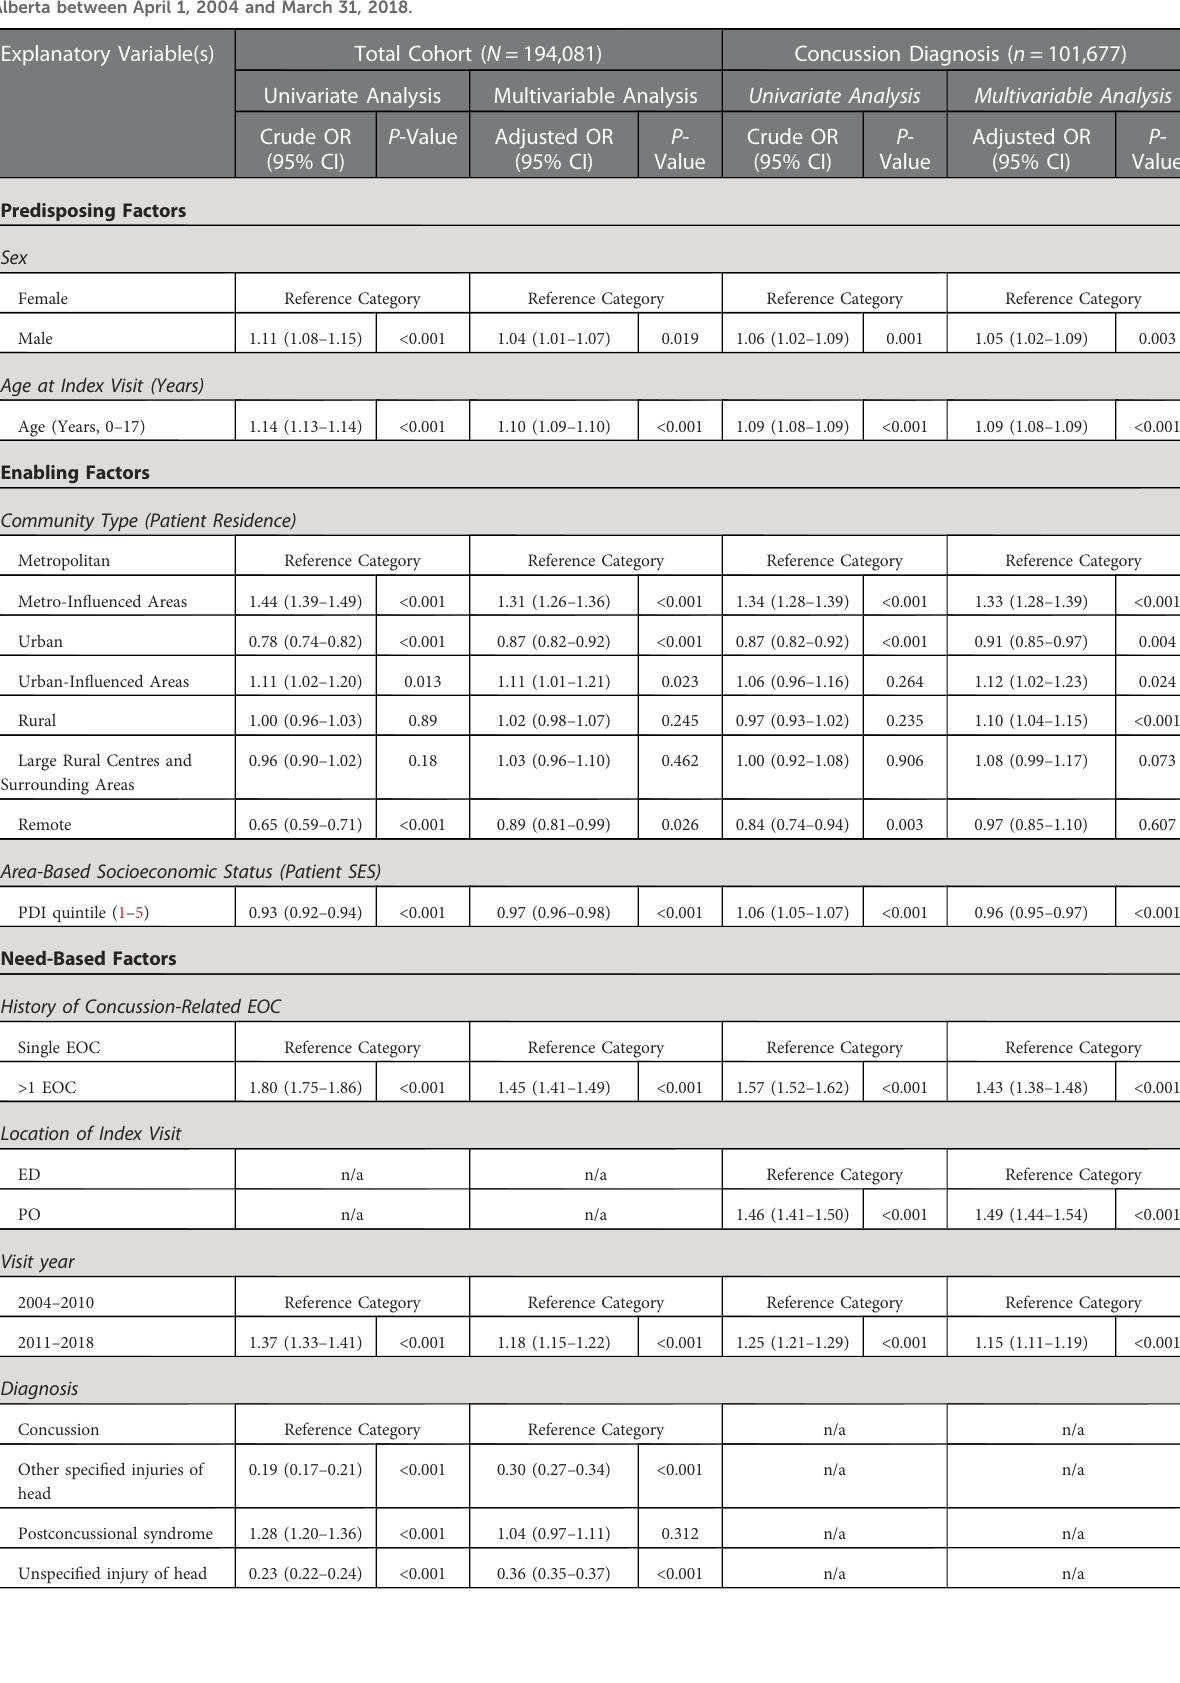
TABLE 6 Univariate and multivariable logistic regression analyses to measure the association between predisposing, enabling, and need factors and follow-up care for pediatric concussion, post-concussion syndrome, other speci fi ed injuries of head, and unspeci fi ed injury of head diagnoses in Alberta between April 1, 2004 and March 31,